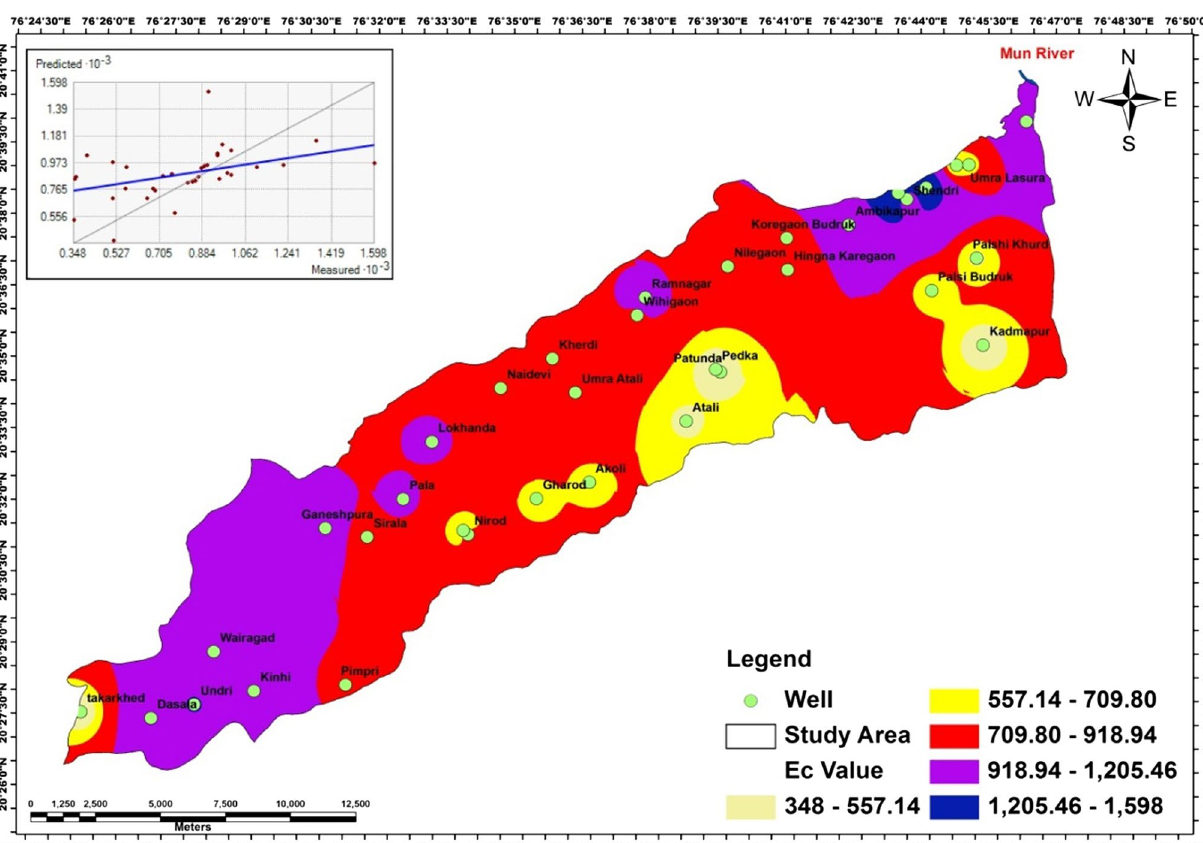
Fig. 4 Spatial distribution map of EC post